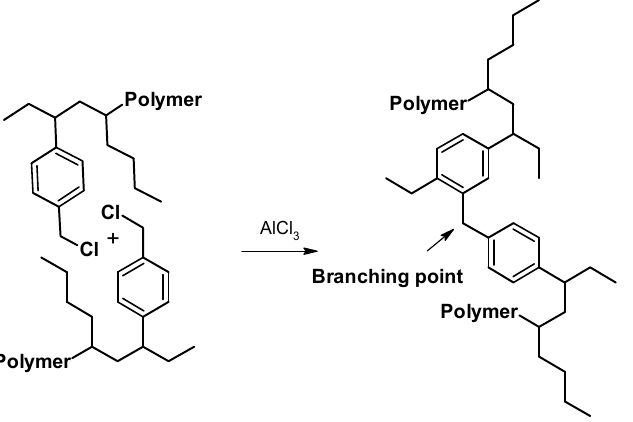
Figure 4. Illustration of the possible branching reaction.